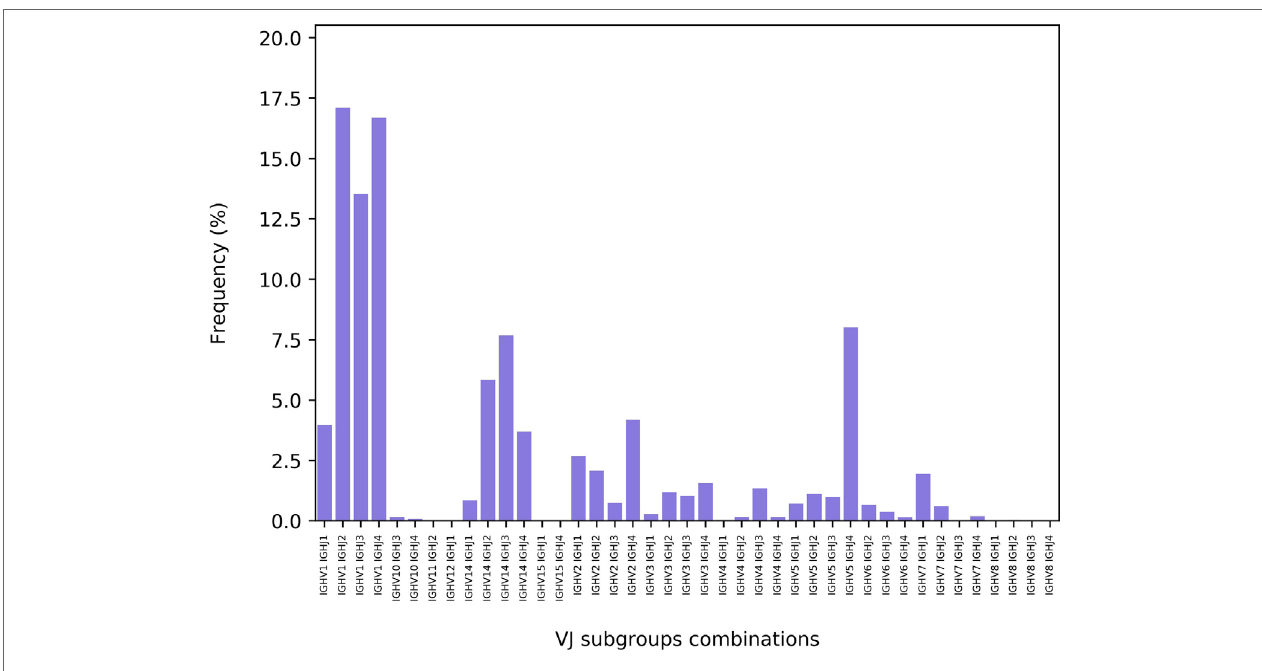
FIguRe 7 | The distribution of the V(D)J combinations in a next-generation sequencing replicate. Shown are the frequencies of the various combinations between the V and J